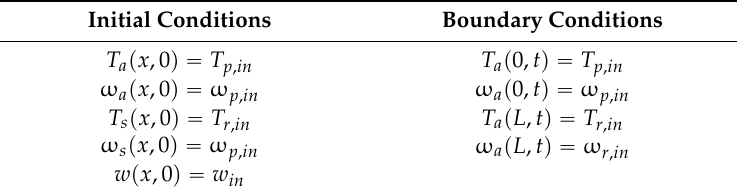
Table 2. Initial and boundary